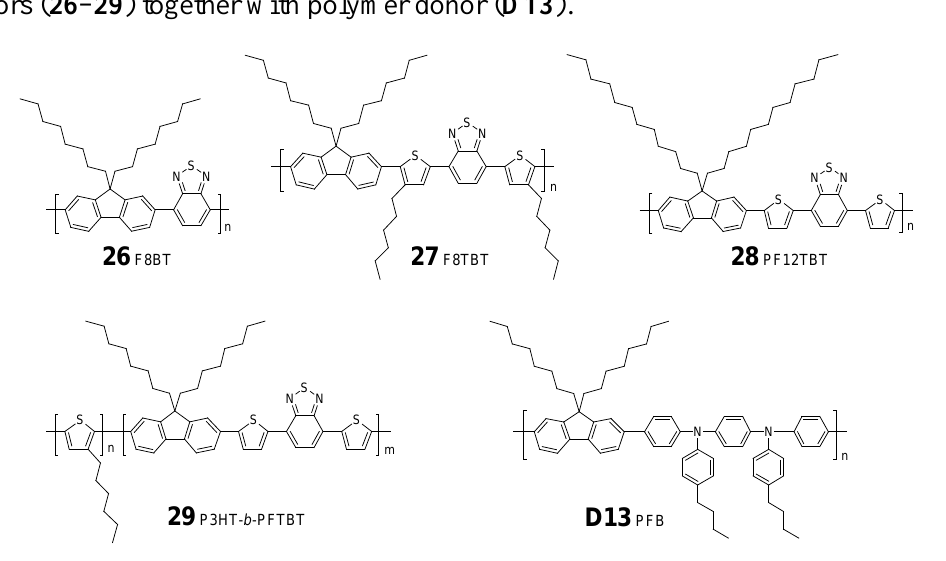
Figure 6. Molecular structures of fluorene and benzothiadiazole (BT)-based polymer acceptors ( 26 – 29 ) together with polymer donor ( D13